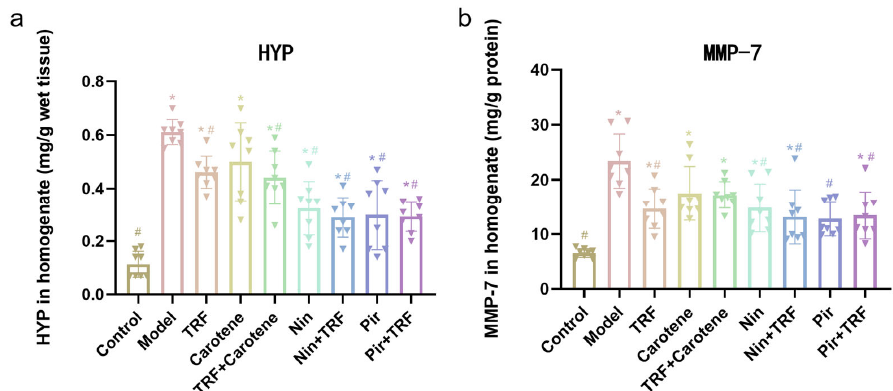
Figure 2. Effects of TRF and carotene on HYP ( a ) and MMP ‐ 7 ( b ) levels of TRF in lung tissue, n = 8. Note: * represents p < 0.05 in comparison to the control group; # represents p < 0.05 in comparison to the model group.